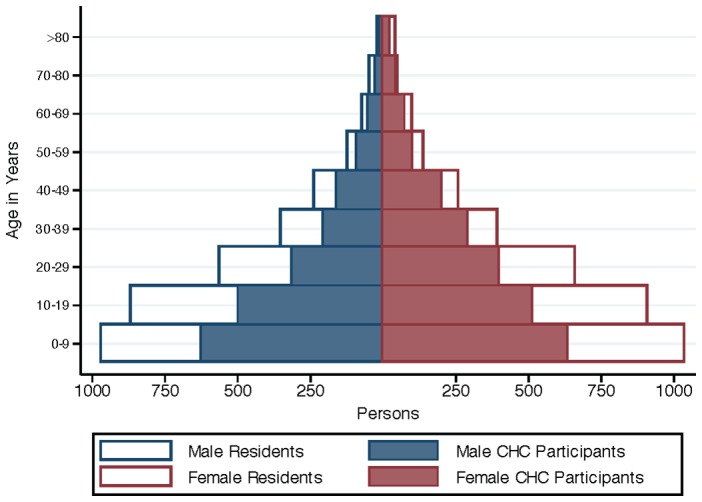
Population distribution of Kakyerere parish as determined from a twelve-day study census (open blue and red bars), and Community Health Campaign participation over five days among residents (solid blue and red bars), by age and sex.